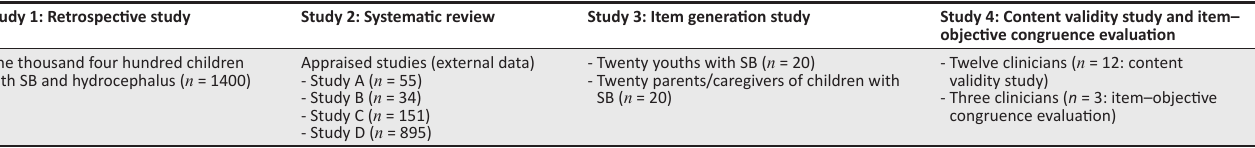
TABLE 1: Study samples for the studies involved in the development of the Zambia Spina Bifida Functional Measure. Study 1: Retrospective study